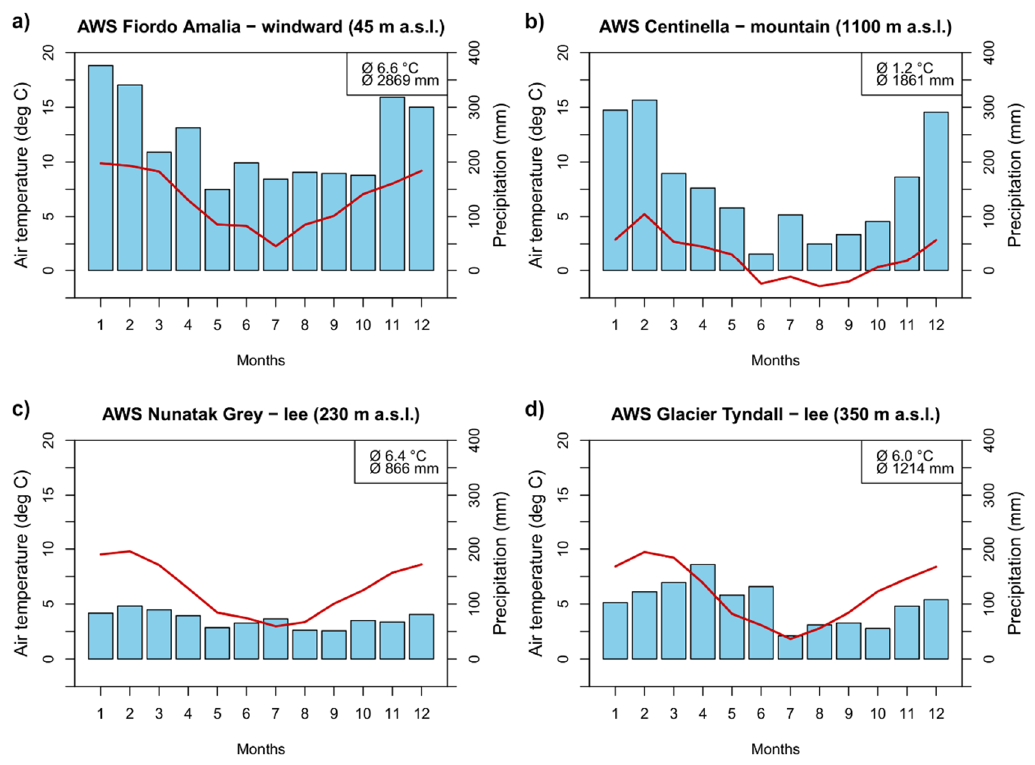
Figure 2. Climate diagrams at ( a ) Fiordo Amalia (FA), ( b ) CE, ( c ) NG and ( d ) Glacier Tyndall (GT) for the respective recording periods presented in Table 1. The station name, position and altitude are given above the respective panel.